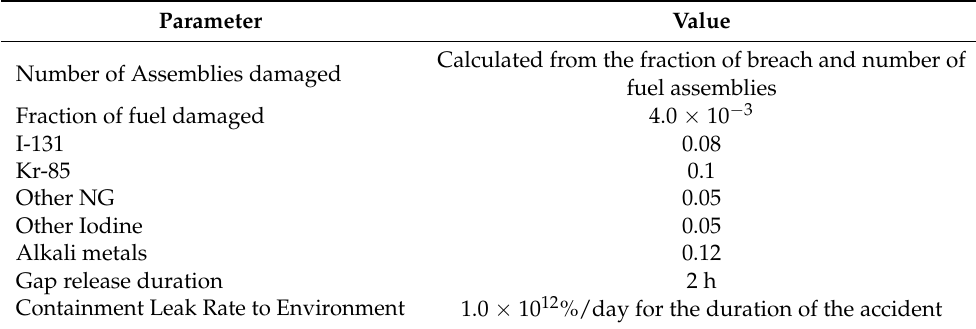
Table 3. Fuel handling accident analysis parameters using